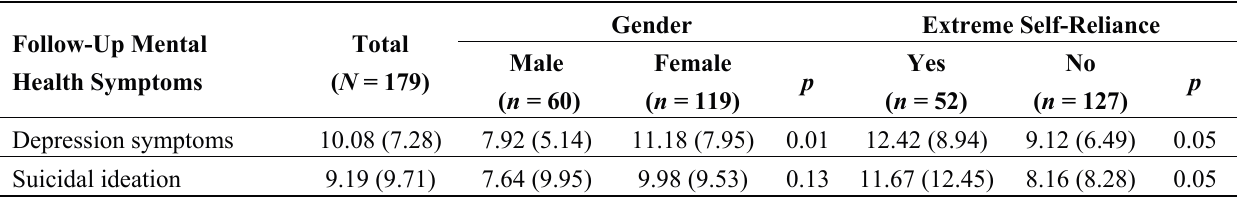
Table 2. Mental health symptoms at two-year follow-up of adolescents identified as at heightened risk for suicidality at baseline who did and did not endorse extreme